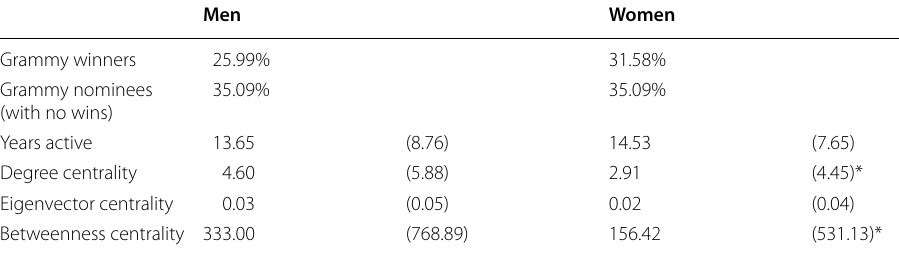
Table 2 Descriptive statistics by artists’